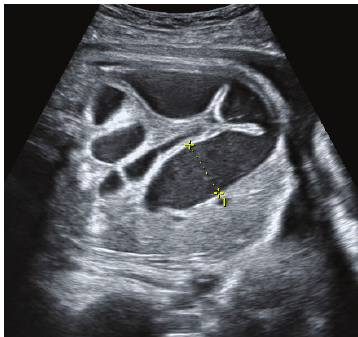
Figure 3: Intestinal loop dilatation with 23 mm at 33rd week.